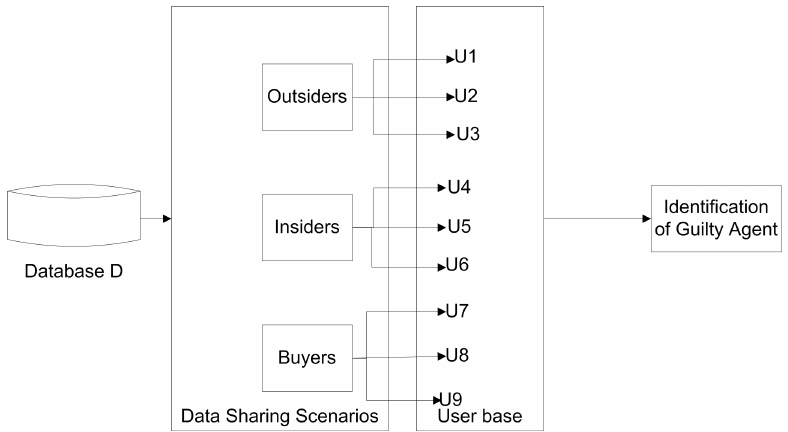
Figure 1. Scenarios of data sharing and data